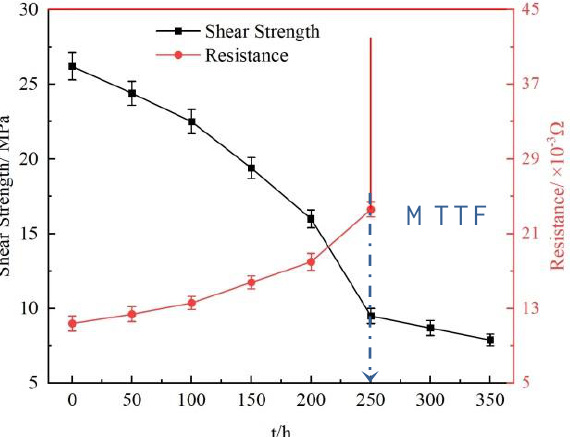
Figure 10. Fitting curve of resistance versus shear strength of solder joints in the current loading (j = 7 × 10 3 A/cm 2 ) process.